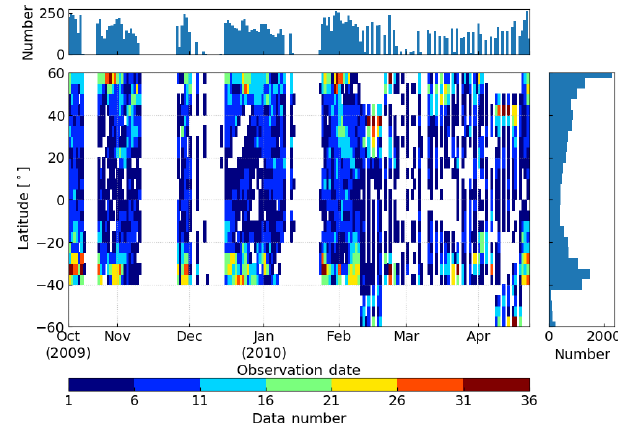
Figure 8. Distribution of the data that meet the criteria between 12 October 2009 and 21 April 2010, at 8.6hPa. Observation date and latitude bins are 1d and 3 ◦ . Table 4. Data quality criteria for the SMILES and